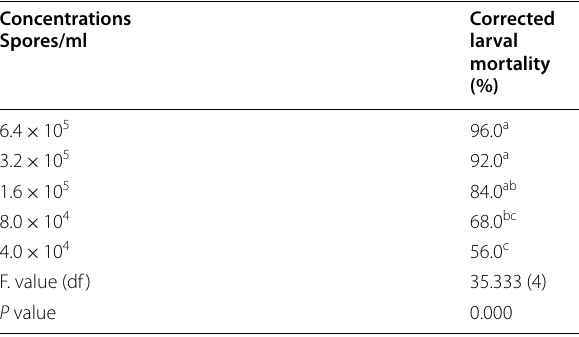
Table 3 Effect of isolated strain of Beauveria bassiana on Galleria mellonila fourth-instar larvae